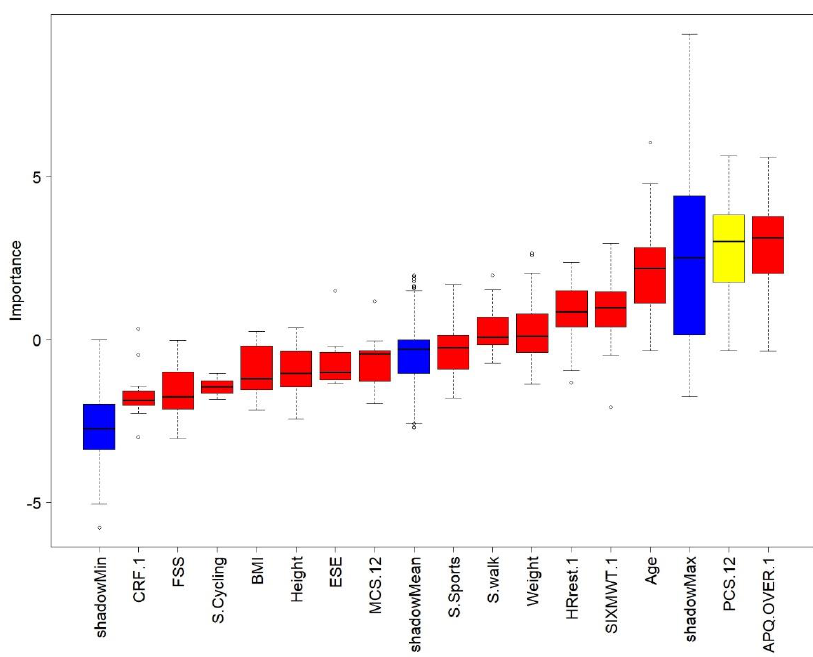
Figure 2. Recursive features elimination, walking minutes. Red color means that the variable is not considered important in predicting walking minutes. Yellow color means that the variable could be important in predicting walking minutes; however, there is a degree of uncertainty left. Blue color distinguishes the randomized copy variables used to assess importance. Int. J. Environ. Res. Public Health 2020 , 17 , x FOR PEER REVIEW